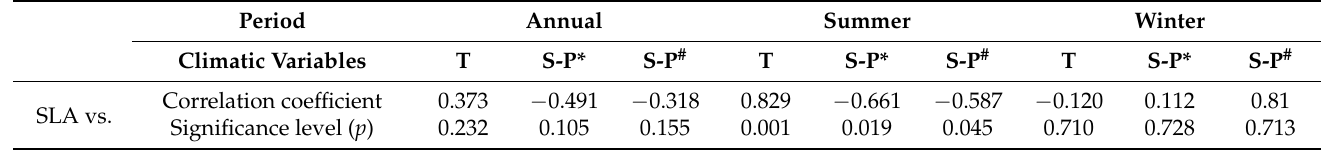
Table 6. The correlation coefficient between the annual mean snow line altitude (SLA) for the study glaciers and the daily temperature (T) and the cumulative solid precipitation (S-P) from Daxigou weather station at different time periods. * represents the solid precipitation threshold of 2.8 °C, and # represents the solid precipitation threshold of 1.0 °C. Period SLA vs.